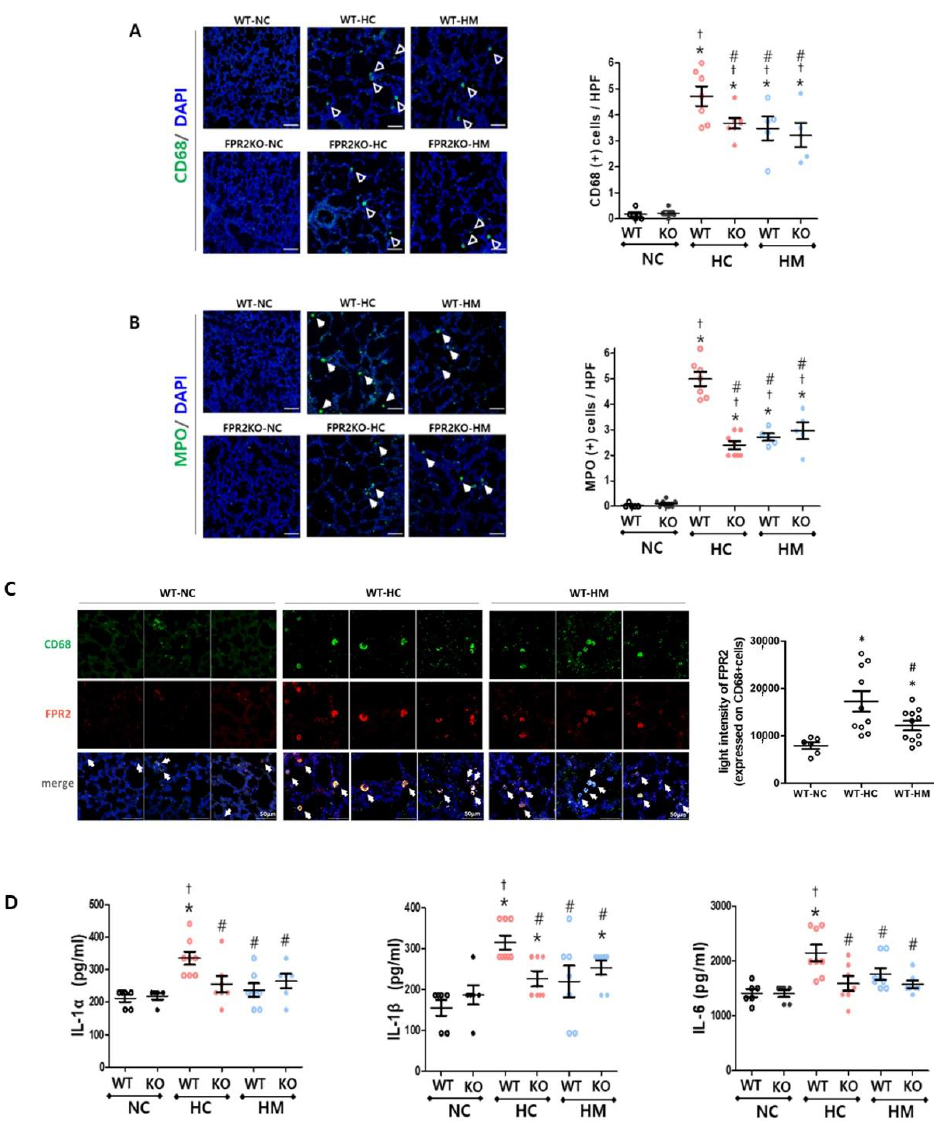
Figure 5. Inflammation in wild-type and FPR2 − / − mouse lungs. Representative photomicrographs of ( A ) cluster of differentiation 68 (CD68; green) and ( B ) myeloperoxidase (MPO; green) with respective quantitative bar graphs. Nuclei were counter-stained with 4 (cid:48) ,6-diamidino-2-phenylindole (DAPI; blue) (scale bar, 50 µ m). ( C ) Representative photomicrographs of double-stained CD68 (green) and FPR2 (red) with quantitative bar graph. ( D ) The levels of interleukin-1 α (IL)-1 α , IL-1 β , and IL-6 measured by enzyme linked immunosorbent assay (ELISA). Data are given as mean ± SEM. * p < 0.05 vs. NC in WT. † p < 0.05 vs. NC in KO. # p < 0.05 vs. HC in WT. WT, wild-type mouse; KO, FPR2 − / − mouse; NC, normoxia control; HC, hyperoxia control; HM, hyperoxia with intratracheal transplantation of human umbilical cord blood-derived MSC